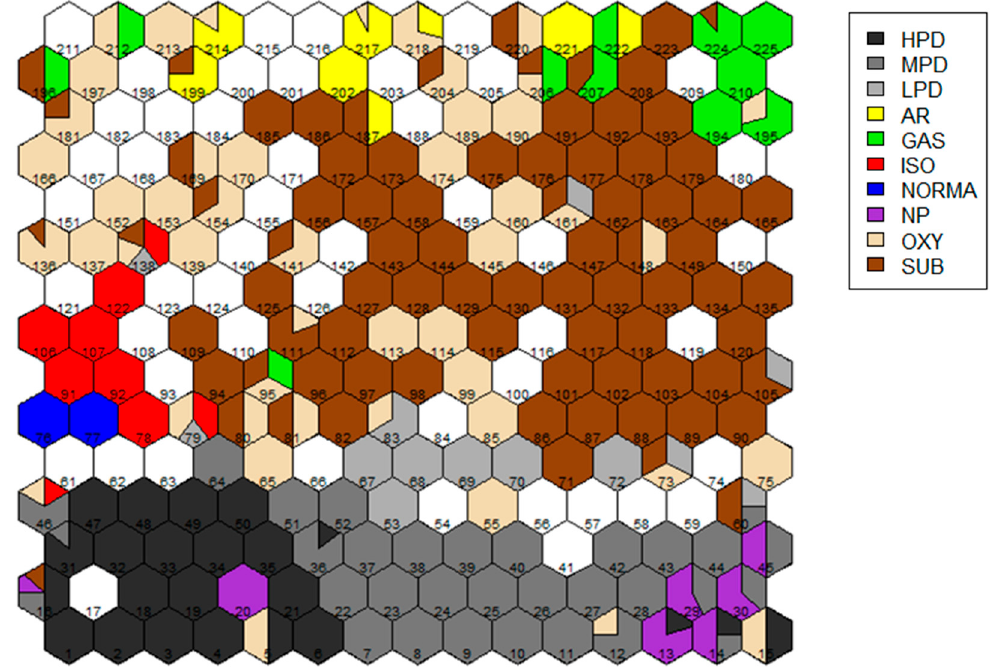
Figure 1. The trained SOM with neurons colored according to their ASTM class designations. See the color legend.